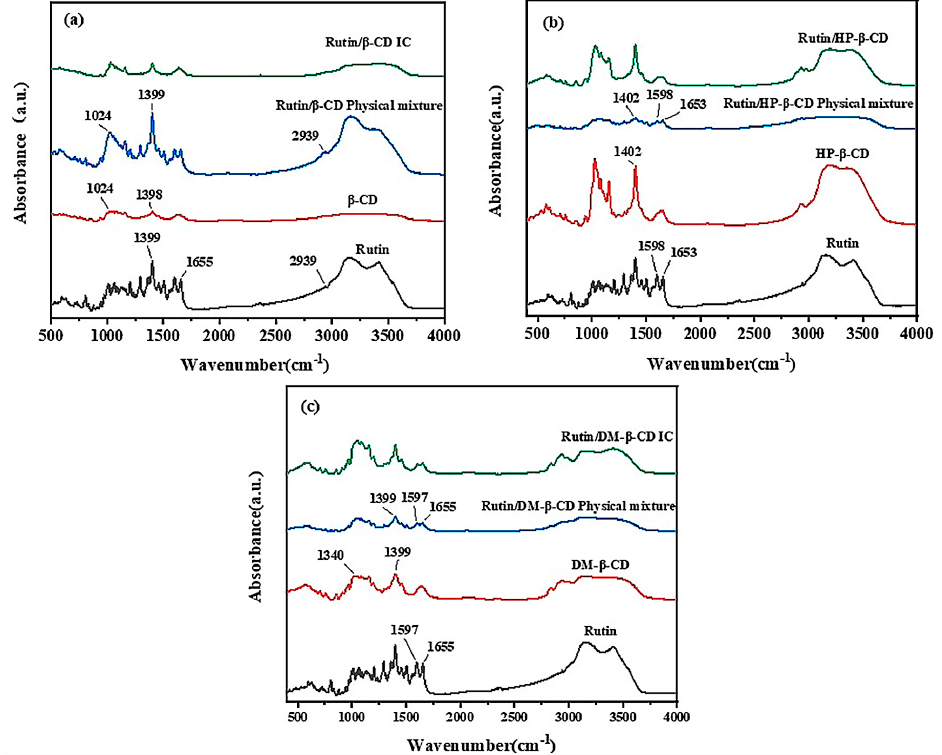
Figure 2. FTIR spectrum of ( a ) rutin, β - CD, physical mixture and inclusion complex; ( b ) rutin, HP - β - CD, physical mixture and inclusion complex and ( c ) rutin, DM - β - CD, physical mixture and inclusion complex.